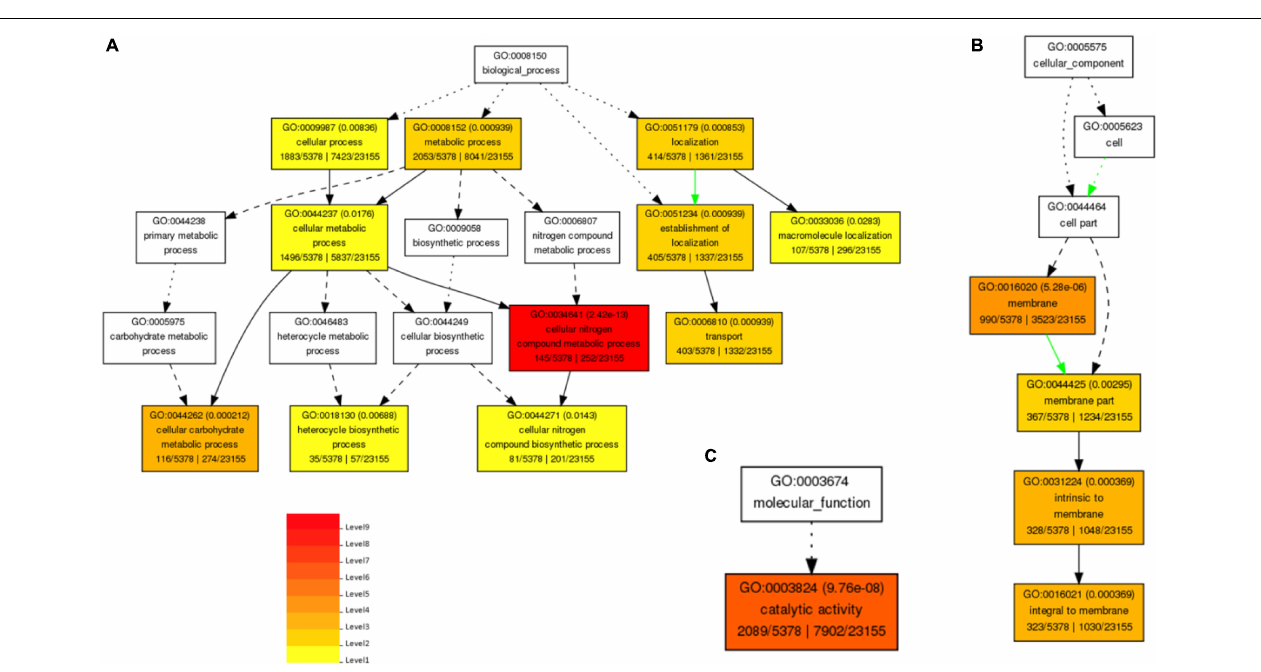
FIGURE 1 | This diagram is showing the expression pattern of DETs among different comparison groups (A) . Venn diagram shows the upregulation of DETs among various treated groups (B) . Venn diagram shows the downregulation of DETs among different treated groups (C) . Here, “S” is indicating salt-treated groups, “CK” is indicating control group, and “h” is used for hours, i.e., 1 h (1 h), 3 h (3 h), and 7 h (7 h).